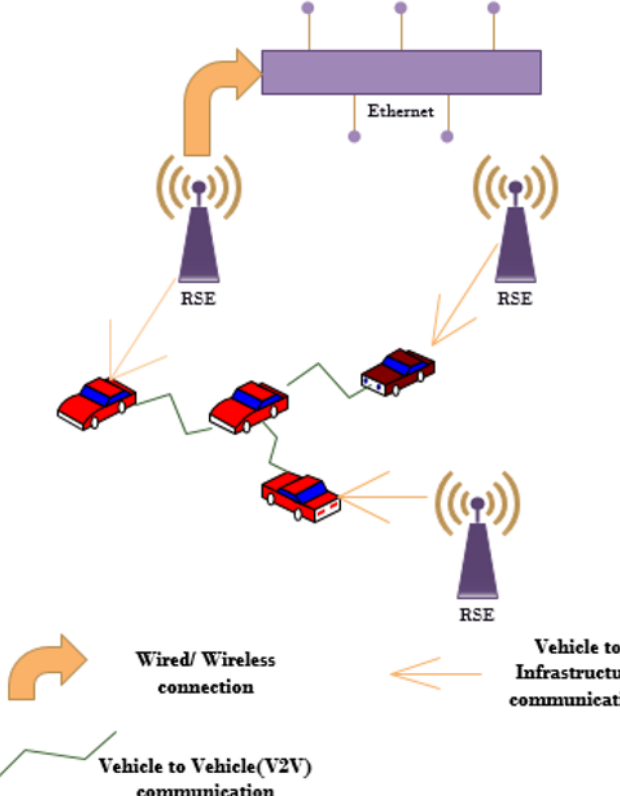
Figure 4. Proposed VANET